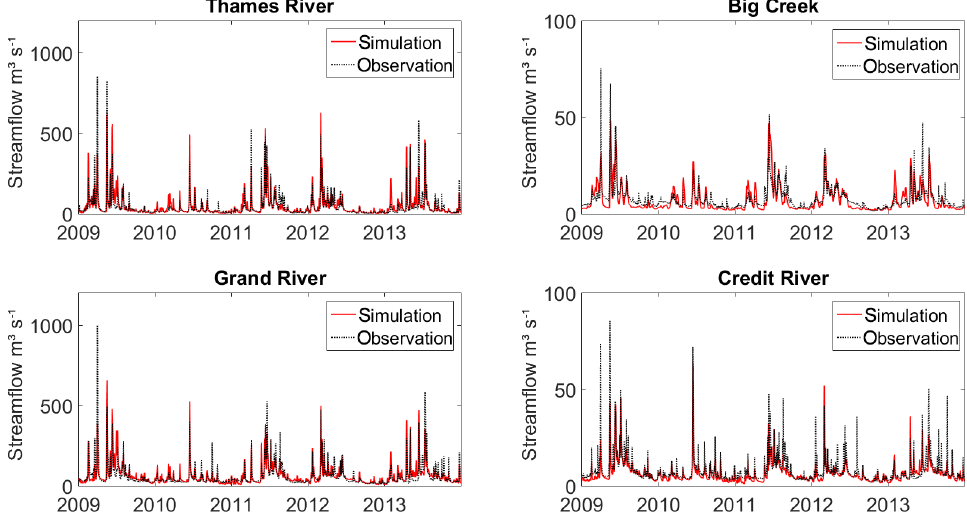
Figure 2. Daily observed (OBS) and simulated (CTL) streamflow during the validation period (2009–2013).